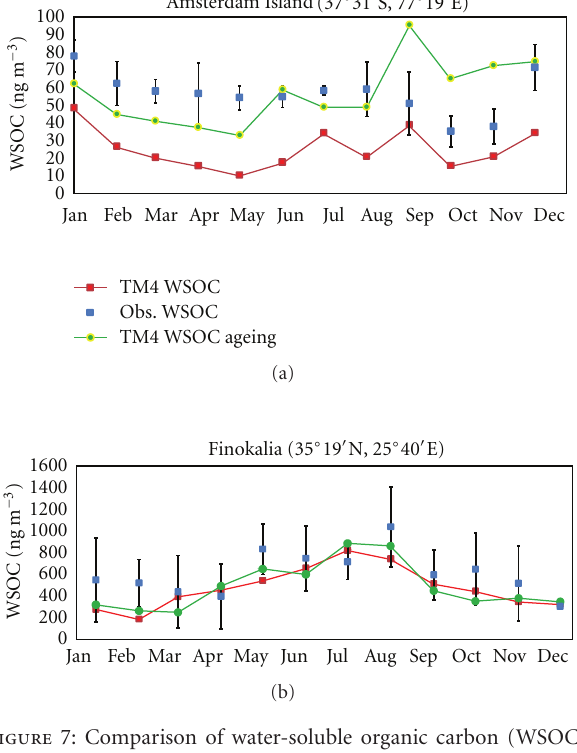
Figure 7: Comparison of water-soluble organic carbon (WSOC) observations with model results. Observed WSOC (blue squares with standard deviation bars) and modelled WSOC-S1 (red line— squares) and WSOC when ageing of marine POA is taken into account (circles and green line) at (a) Amsterdam Island (37 ◦ 31 (cid:5) S, 77 ◦ 19 (cid:5) E) [41] and (b) Finokalia (35 ◦ 19 (cid:5) N, 25 ◦ 40 (cid:5) E) [42]. All values are in ng m − 3